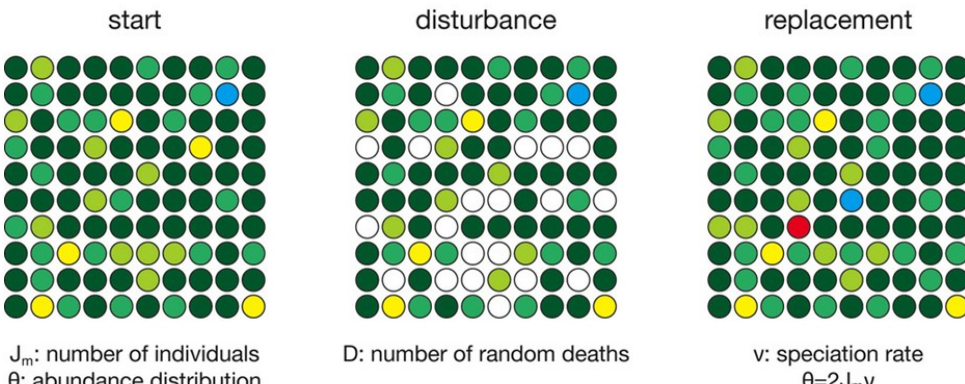
Figure 1. Schematic illustration of the simulation steps, showing a metacommunity composed of individuals of different species, indicated by colors. In each time step, some individuals die, clearing a site (white) for replacement by individuals of other species or possibly new species